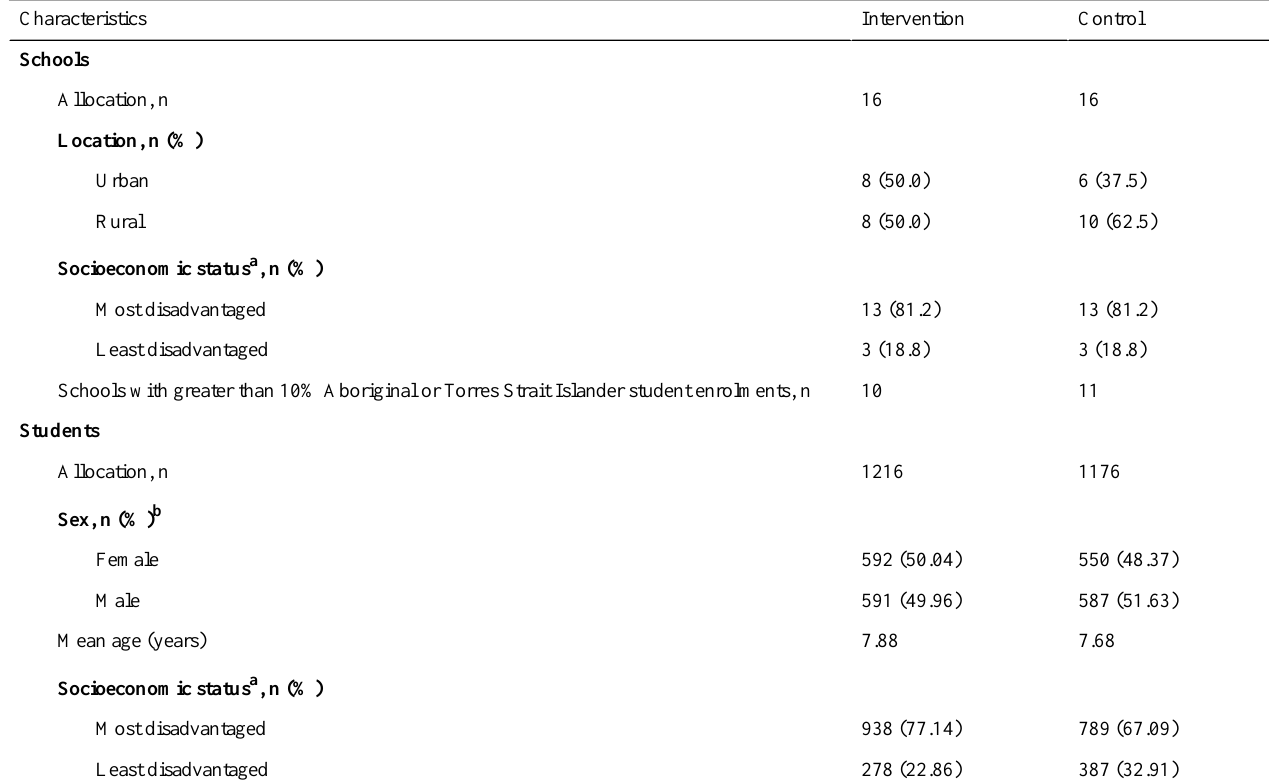
Table 1. Sample characteristics of schools and students at